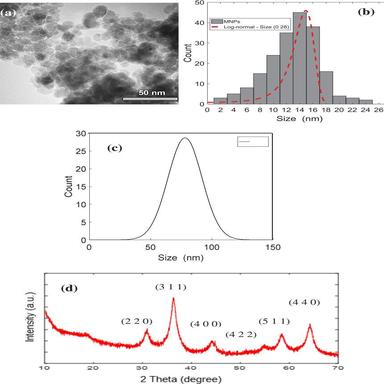
(a) TEM image of the nanoparticles. (b) Histogram of the size distribution of the Fe3O4 nanoparticles. (c) Particle size distribution of magnetic nanoparticles obtained by the DLS technique. (d) XRD of the Fe3O4 nanoparticles.